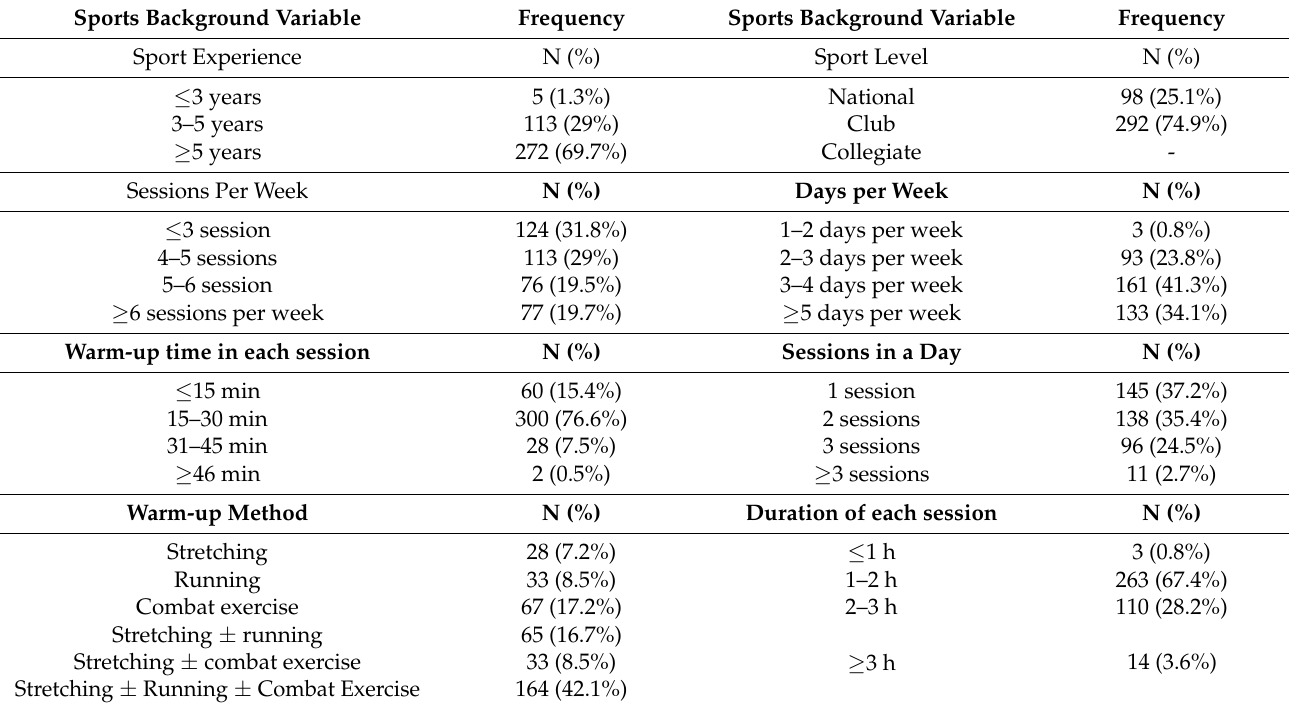
Table 1. Participants’ sports background information.